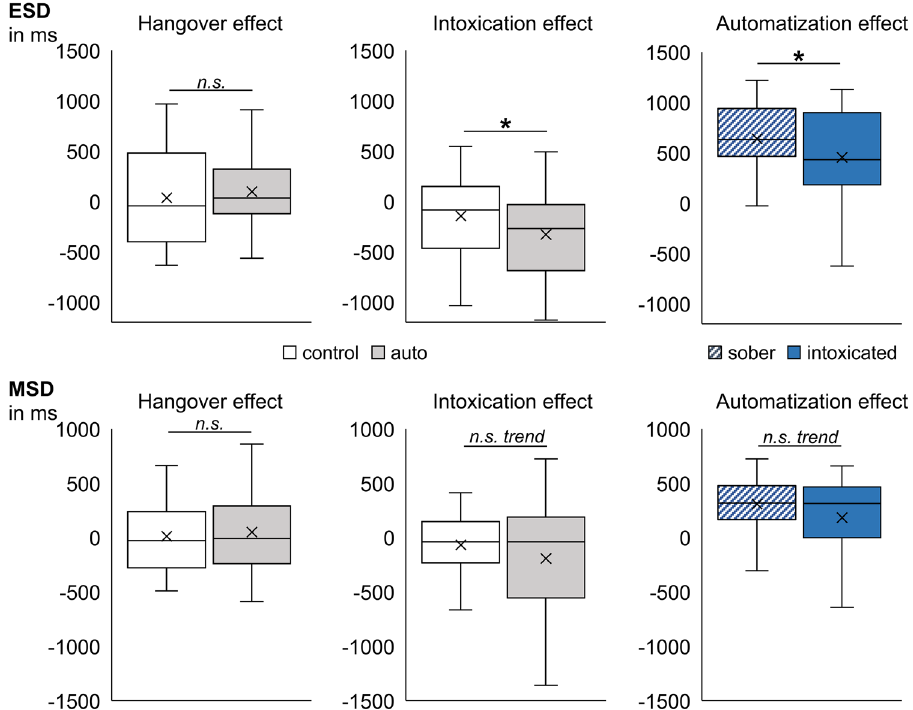
Figure 2. Illustration of the three-way interaction of alcohol administration x condition x alcohol manipulation group found for the entire sequence duration (ESD in milliseconds; upper graph) and for the motor sequence duration (MSD in milliseconds; lower graph). While there were no overall hangover-induced effects on task conditions, intoxication-induced impairments (i.e., the difference between sober and intoxicated performance) were significantly larger in the auto condition than in the control condition for the ESD measure and showed a corresponding trend for the MSD measure. Likewise, the size of the ESD automatization effect (i.e., the difference between control and auto condition) was significantly smaller at the intoxicated appointment than at the sober appointment and showed a corresponding trend for the MSD measure. This suggests that the planning, as these ESD effects were observed for the MSD, but not the RT1